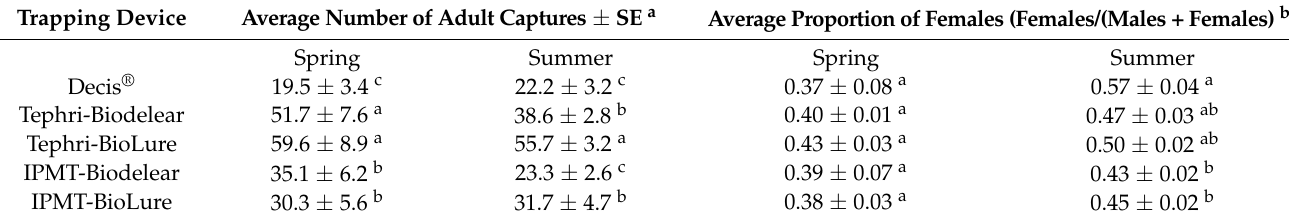
Table 2. Captures of adults (both males and females) and the proportion of females in the five mass trapping devices during the spring and summer trials in the field cages. Ten replicates (different experimental dates) were run in each season. A total of 50 males and 50 females were released in each field